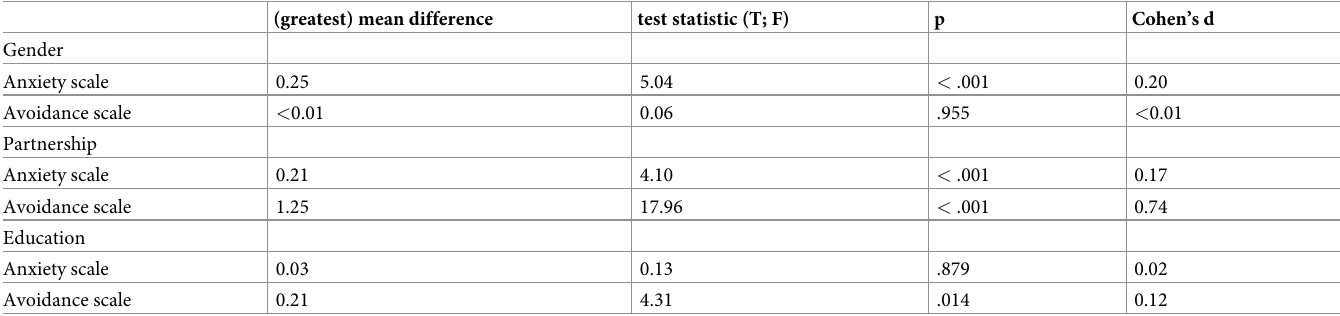
Table 8. Influence of sociodemographic